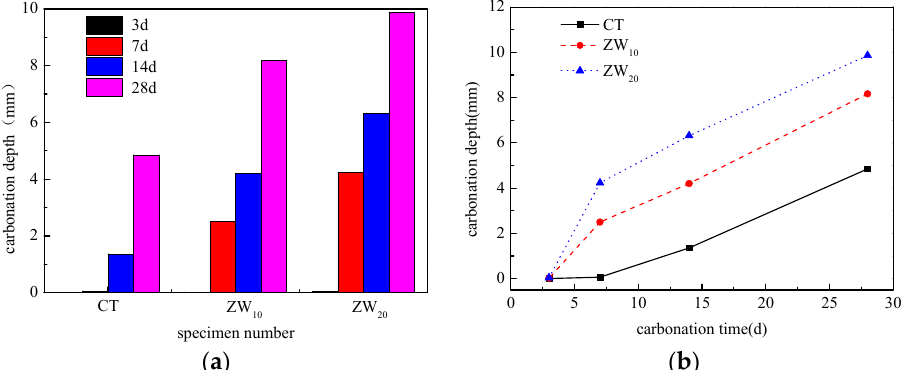
Figure 7. ( a ) Carbonation depth histogram and ( b ) carbonation depth-time curve of concrete with different content of CANCP.